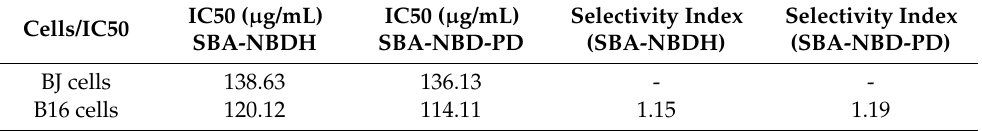
Table 4. IC50 values of SBA-15-NBD derivates against BJ and B16 cells and their selectivity indexes.